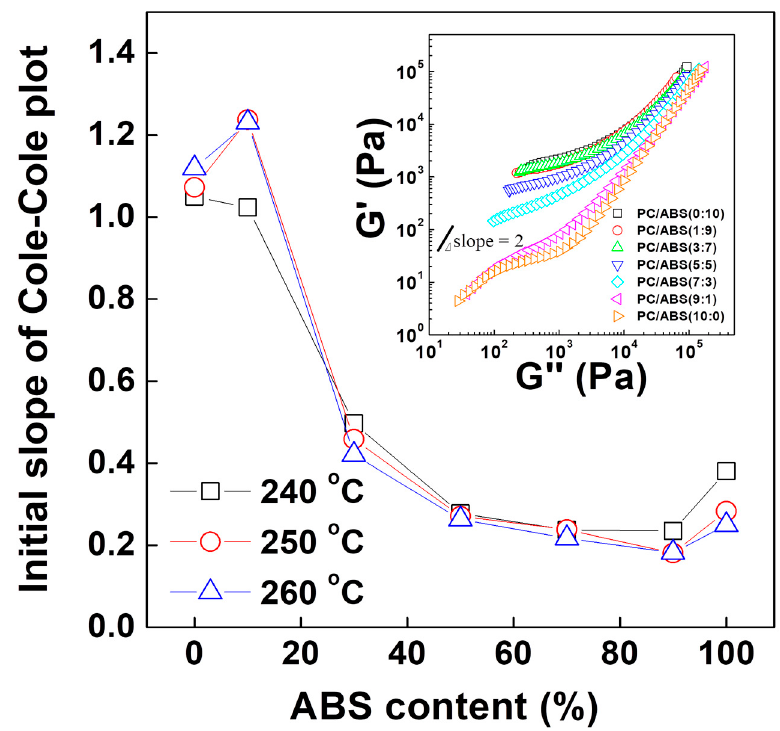
Table 3. Initial slopes of modified Cole ‐ Cole plot of PC/ABS blends.